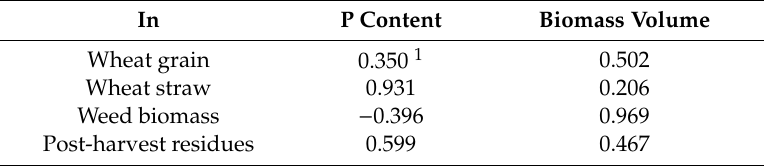
Table 11. Dependence of P accumulation on P content and biomass volumes of plant biomass parts—simple correlation coe ffi